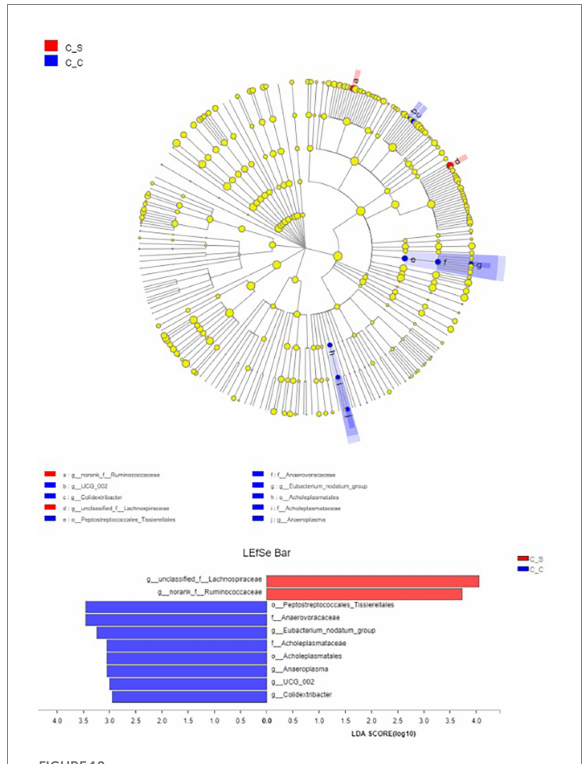
FIGURE 10 Column diagram of LDA value distribution (default set to 4) and evolutionary branch diagram. In the Figure, C ▬ S represents the HT group and C ▬ C represents the appropriate temperature group, n